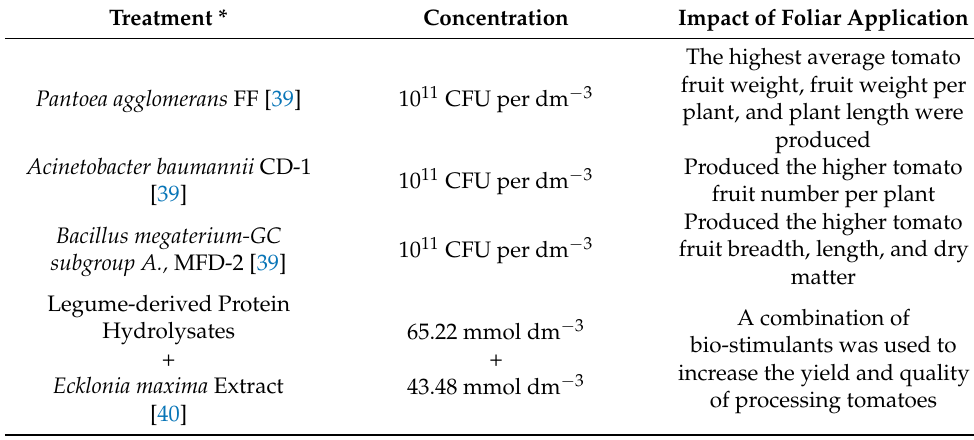
Table 6. Impact of foliar nutrition with biological treatments in